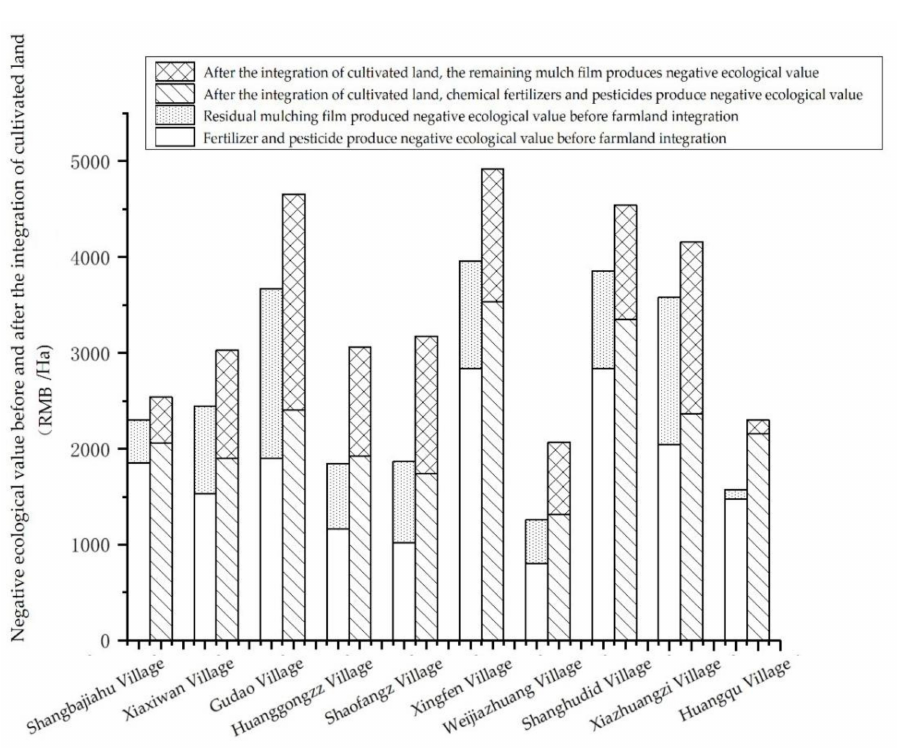
Figure 6. Negative pro-ecological value of cultivated land before and after integration. As can be seen from the above figure, the negative value of pesticides, fertilizers, and residual mulch film after the integration of farmland in various villages increased greatly, of which the value of fertilizers and pesticides had a relatively large value. Shao- fangzhuang Village had the highest pro-ecological negative value after integration, with the highest increment in value of RMB 1305.5/ha, followed by Huanggongzhuangzi Village, with a negative value increase of RMB 1213.21/ha. On the contrary, the pro-ecological negative value generated after the integration of the cultivated land in Xiaxiwan Village and Shangbajiahu Village was the lowest; the changes in value were RMB 518.98/ha and RMB 246.7/ha, respectively. From the overall negative value, it can be seen that the four villages located in the Manas Oasis agricultural area had higher pro-ecological negative values before and after the integration, followed by the four villages located in the oa- sis/desert interlaced area and the two villages in the upper low mountain and hilly